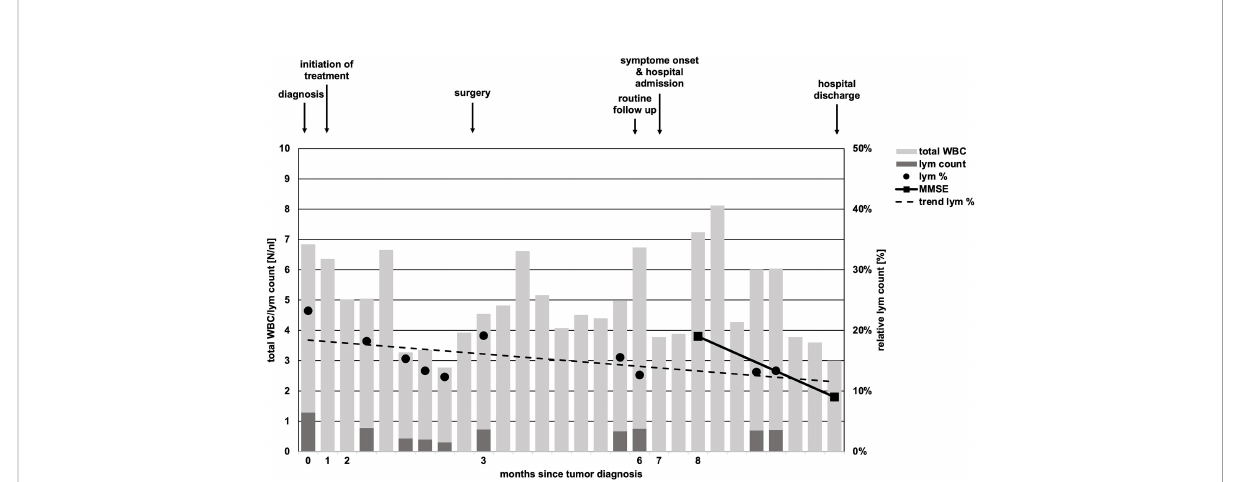
FIGURE 2 Timeline of total white body cell and lymphocyte count. While total white body cell (WBC) count (light grey bars) undulated in course of disease, absolute lymphocyte (lym) count (dark grey bars) was constantly low and never reached pre-treatment levels in course of time. Relative lymphocyte count (black dots, lym %) showed a trend of decline (scattered black line, trend lym %). Missing black dots/dark gray bars represent missing laboratory parameters regarding lymphocyte counts. Arrows above chart indicate initiation of chemotherapy, time of surgery, follow-up, onset of neurologic symptoms in course of PML and hospital